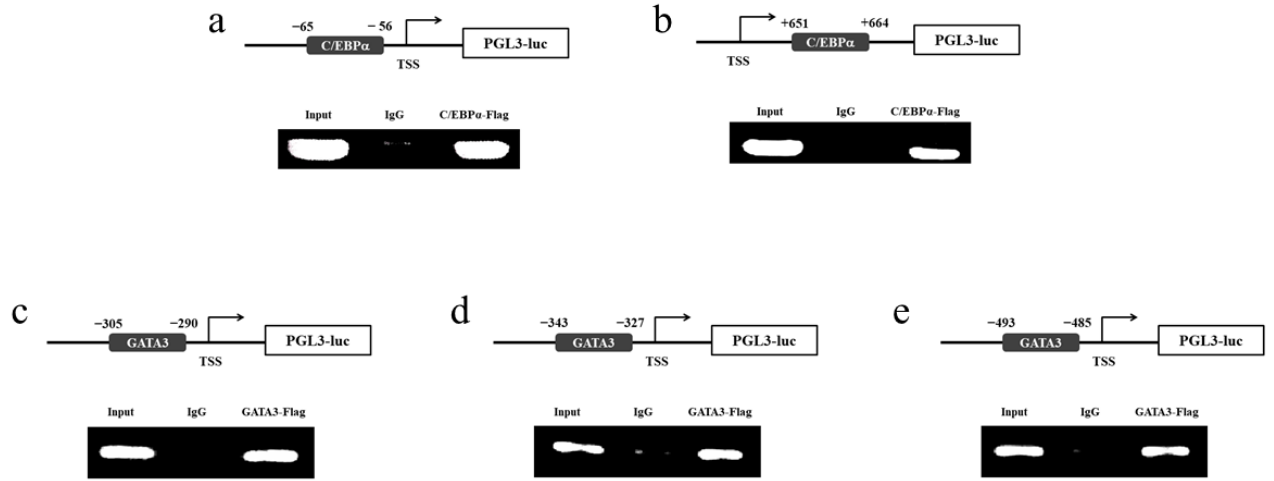
Figure 9. ChIP assay. Identification of C/EBP α binding sites in region of the fads2 promoter in large yellow croaker ( a ) and rainbow trout ( b ), identification of GATA3 binding sites in region of the fads2 promoter in large yellow croaker ( c ) and rainbow trout ( d , e ).